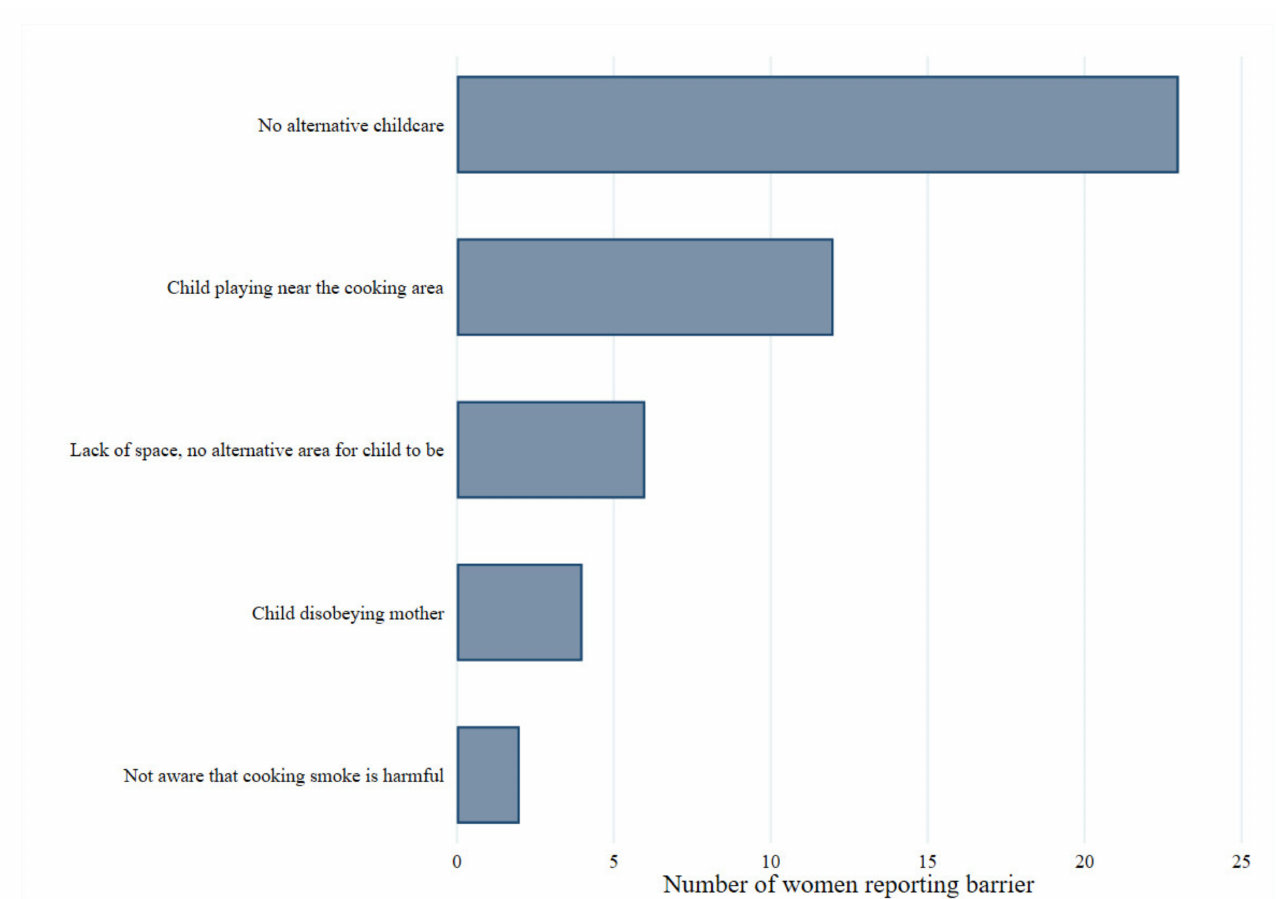
Figure 4. Reported barriers to preventing child’s exposure to the